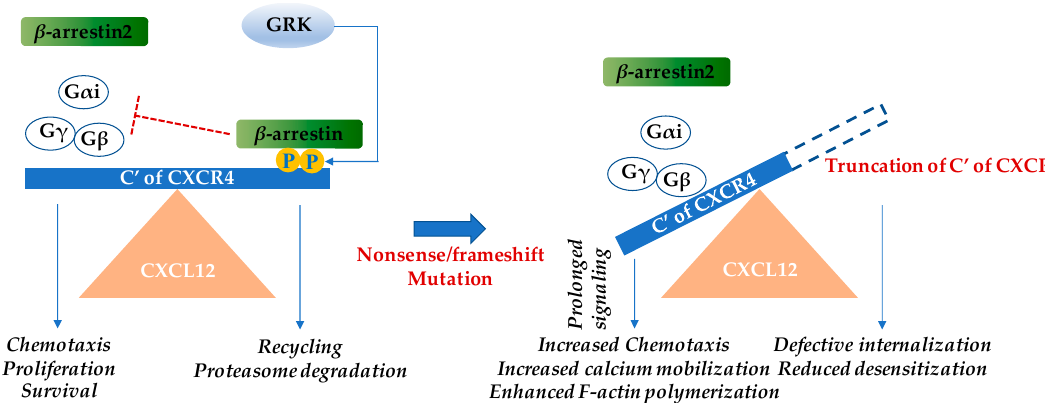
Figure 1. Warts, hypogammaglobulinemia, infections, and myelokathexis (WHIM) mutations in the cytoplasmic region of the cysteine-X-cysteine chemokine receptor CXCR4 result in gain-of-function. Upon CXCL12 binding, CXCR4 undergoes conformational changes and the intracellular trimeric G-protein is activated. The G α subunit dissociates from the βγ -subunit and various pathways including the Ras/Raf/ERK (extracellular regulated kinase), PI3K (phosphoinositide 3-kinase), PLC (phospholipase C), PKC (protein kinase C), and mitogen associated protein kinase (MAPK) pathways are activated. These subsequently result in chemotaxis, increased proliferation, and cell survival [11]. β -arrestin 2 also augments chemotaxis by enhancing p38 MAPK activation [9,12]. Inhibition of CXCR4 signaling occurs by the β -arrestin pathway. CXCL12 binding recruits GPCR kinase (GRK), which induces site-specific phosphorylation at the C -terminus of CXCR4. β -arrestin associates with CXCR4 and triggers receptor internalization. Subsequently, either the chemokine receptor is recycled back to the cell surface or it is degraded by the proteasome. In WHIM syndrome, most mutations cause truncation of the C -terminus of CXCR4 and the phosphorylation sites of GRK for β -arrestin docking are no longer available, leading to reduced desensitization and prolonged signaling [8,10]. The blue arrows indicate induction, while the red “T” bar denotes inhibition.